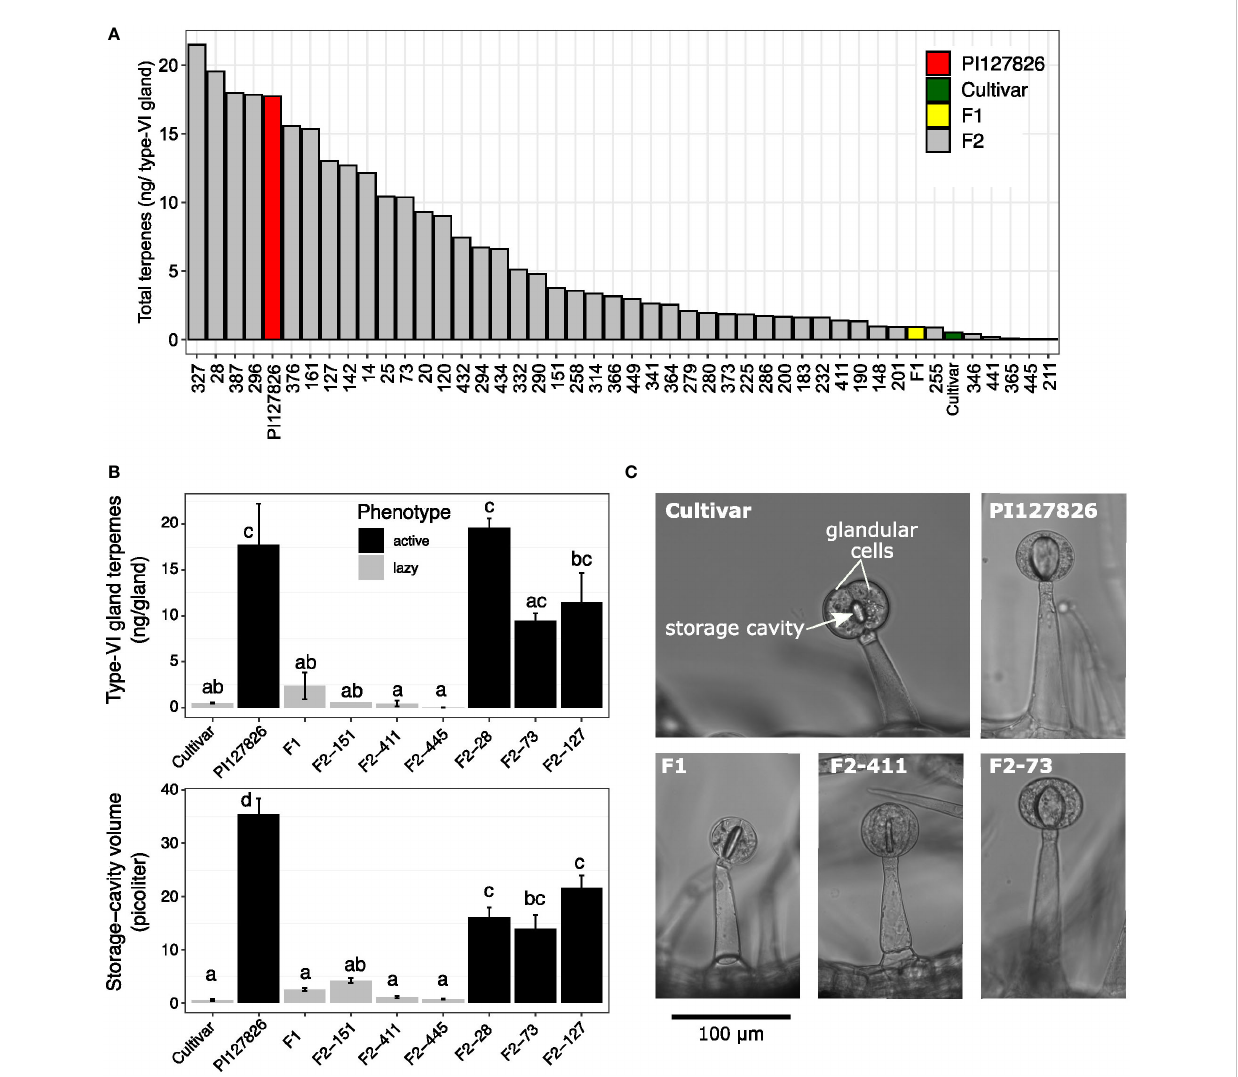
FIGURE 3 Volatile levels in relation to type-VI trichome densities of the F2 progeny. (A) Total amount of mono-and sesquiterpenes per type-VI glandular head of the selected F2-individuals (n = 1) and their parents. (B) Representative photographs showing the middle section of type-VI trichomes on the parental genotypes and an active (F2-73) and lazy (F2-411) F2 individuals. Visible are two glandular cells surrounding the central-storage cavity. (C) Quanti fi cation of the storage-cavity volume (upper panel) of type-VI trichomes (n = 10-20) and total mono-and sesquiterpenes per gland (lower panel) of the selected active (black bars) and lazy (grey bars) F2-genotypes and the parents (n = 3). Letters indicate signi fi cant groups (p < 0.05) according to Tukey HSD post-hoc test after